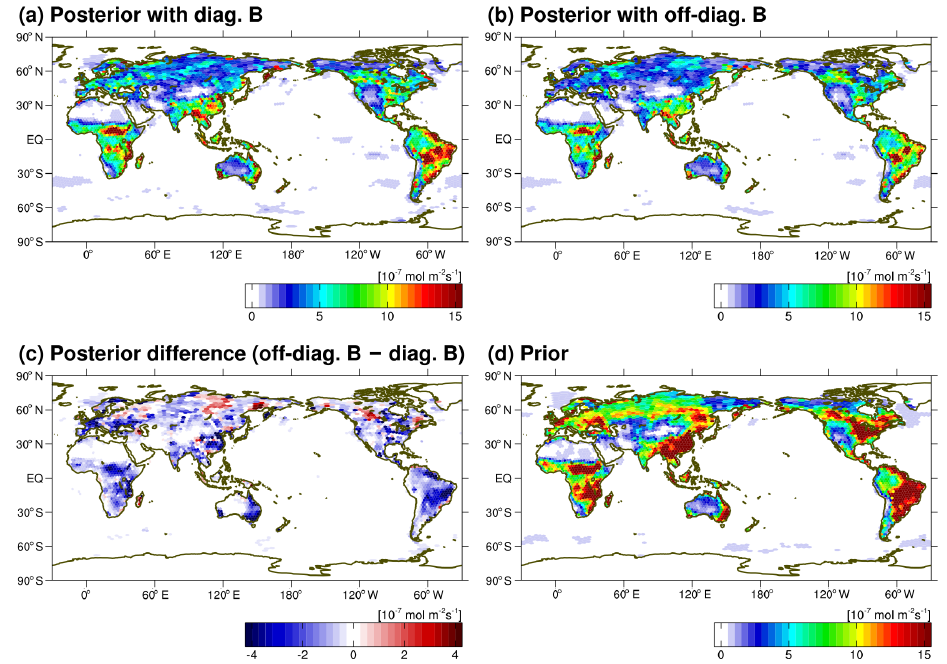
Figure 5. RMSE distributions of the posterior fluxes derived by POpULar+NONLINEAR with the diagonal B (a) and the off-diagonal B (b) . The difference between (b) and (a) is shown in (c) as well as the RMSE distribution of the prior flux (d) .